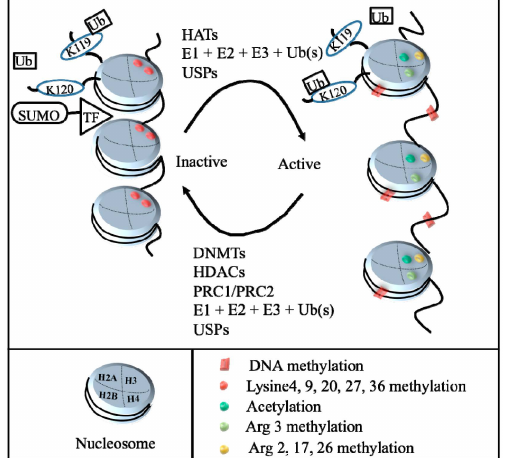
Figure 1. Illustration of epigenetic mechanisms. The process of DNA condensation and relaxation is controlled principally through histone post-translational modifications, such as methylation, acetylation, phosphorylation, ubiquitination, sumoylation, etc . Histone acetyltransferases (HATs), mono- and poly-ubiquitination, and ubiquitin-specific proteases (USPs) may cause uncoiling chromatin (euchromatin) and allow transcriptional factor access to the DNA (right); whereas DNA methyltransferases (DNMTs), histone deacetylases (HDACs), mono- and poly-ubiquitination (Ub), ubiquitin-specific proteases (USPs), Polycomb repressive complex 1(PRC1)/Polycomb repressive complex 2 (PRC2), and Small ubiquitin-related modifier (SUMO) modification may result in coiling chromatin (heterochromatin) and prevent transcription factor access to DNA, leading to transcriptional repression. TF: transcription